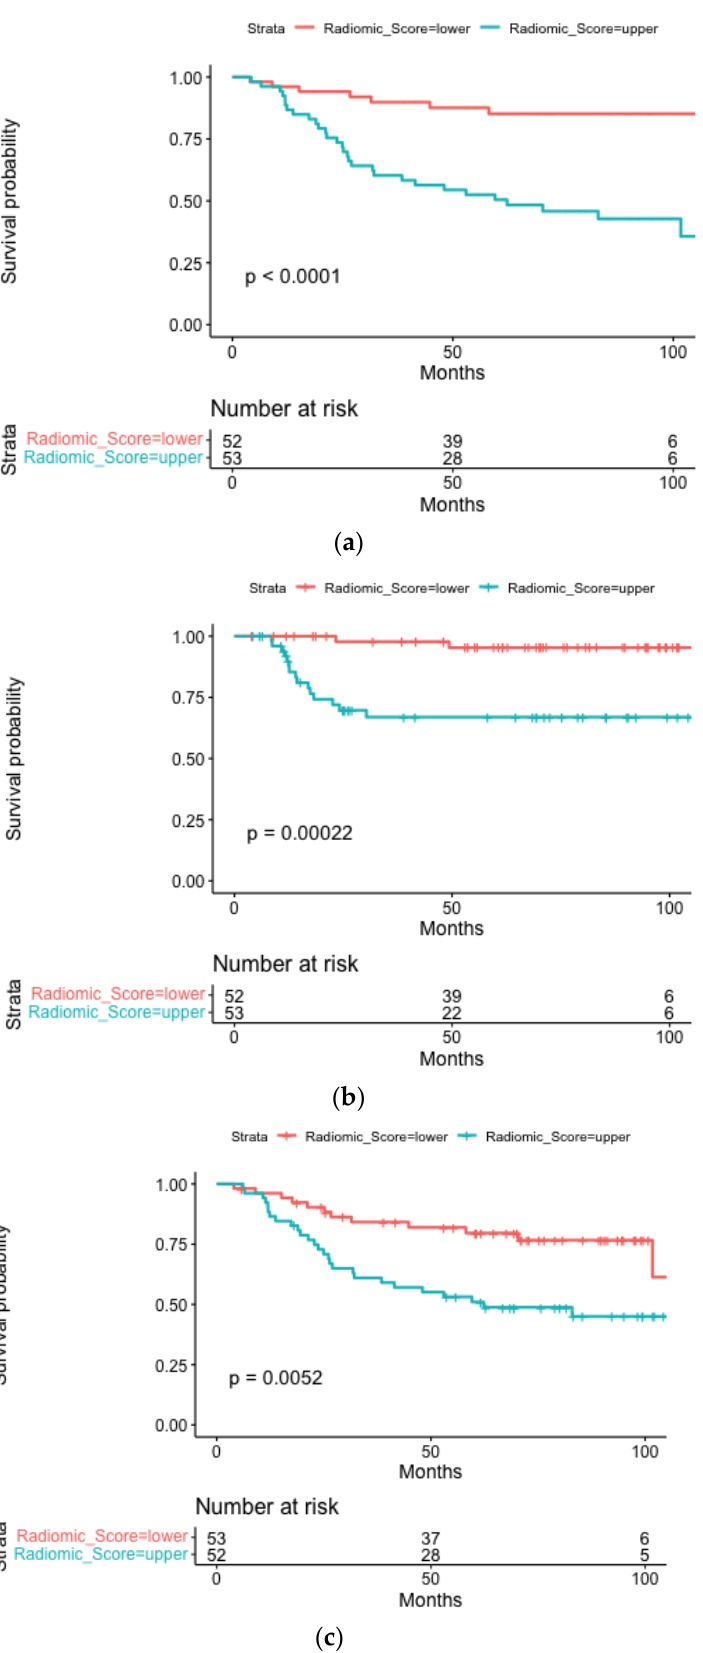
Figure 1. Kaplan-Meier curves stratified according to the radiomics score depicting OS ( a ), LRPFS ( b ) and DMFS ( c ) for the whole population. Repeated 10-fold cross-validated C-index can be seen in Table 3 for both training and test sets ; for OS, the clinical model (median test C-index 0.78, IQR 0.76–0.81) is similar to the pure radiomic model (median test C-index 0.77, IQR 0.75–0.80), while the clinical-ra-